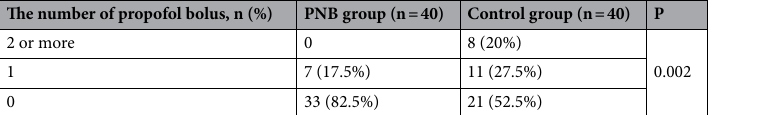
The number of propofol bolus, n (%) PNB group (n = 40) Control group (n = 40)